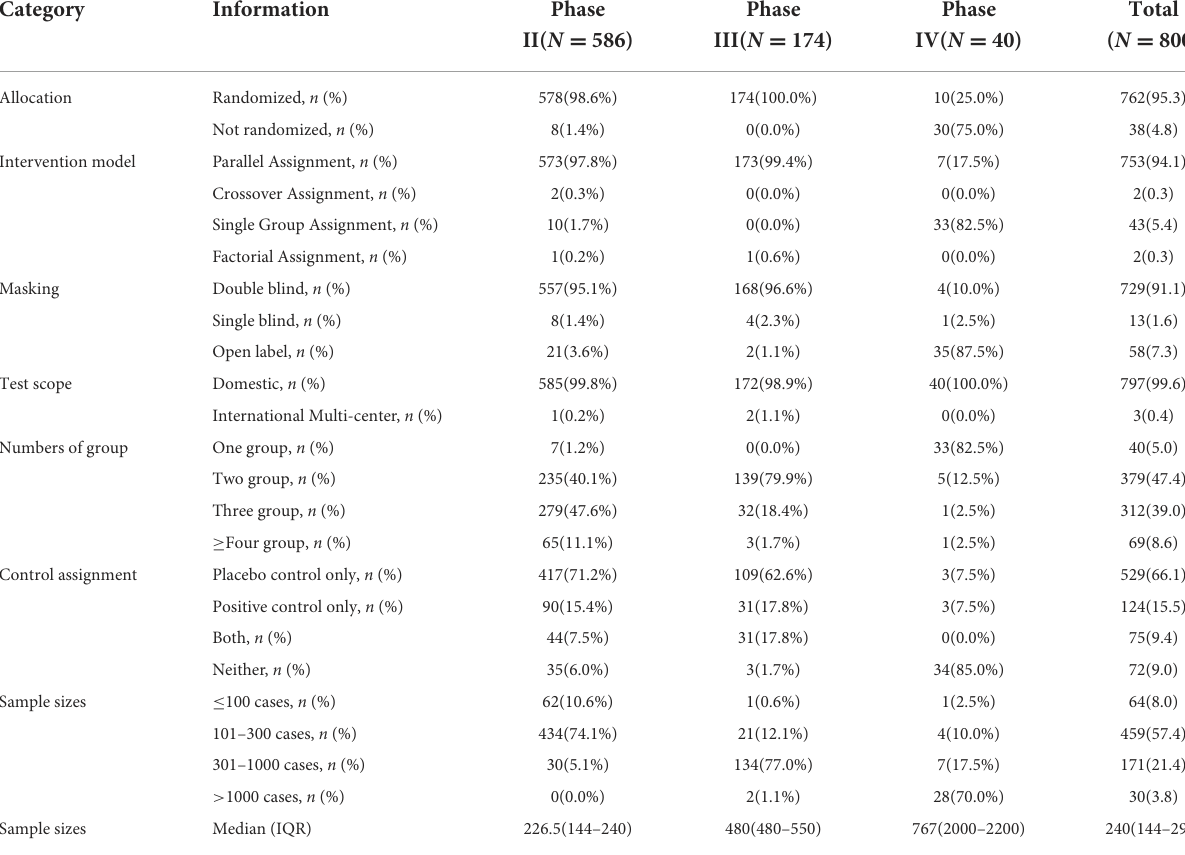
TABLE 1 Trial characteristics and designs for phase II–IV